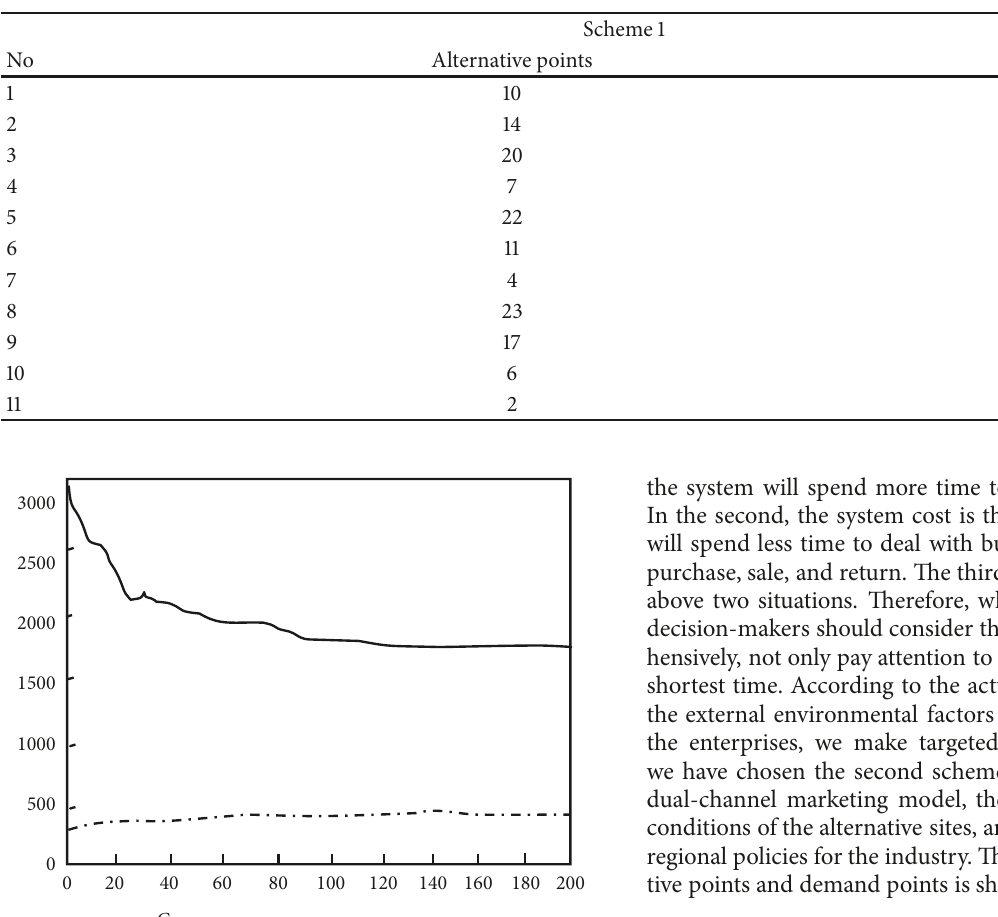
Table 9: The relationship between location and demand distribution of scheme 1.